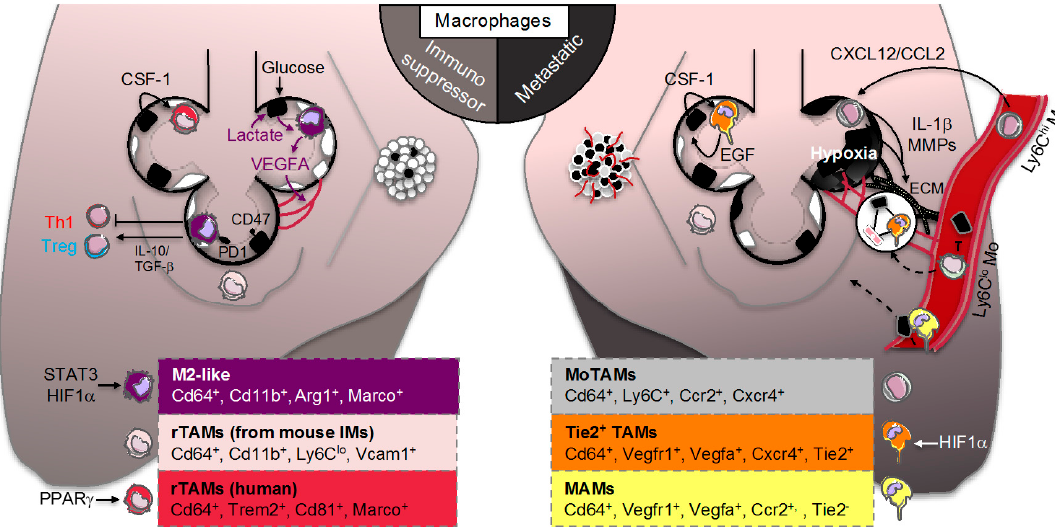
Figure 2. Macrophage effector functions as part of the 7th hallmark of cancer. Right panel: In established tumors, tumor-associated macrophages (TAMs) are the major part of the immune infiltrate that constitutes the tumor microenvironment (TME). Malignant cells produce the colony stimulating factor 1 (CSF-1), which participates to the conversion of tissue-resident macrophages into resident-TAMs (rTAMs). Their origin and cell surface makers may differ between mice and humans, with PPAR γ being highly expressed in human rTAMs. Tumor cells also produce lactate through anaerobic glycolysis referred as the “Warburg effect” that can feed cancer cells in a cell-autonomous fashion for proliferation or act in a paracrine fashion to stabilize the hypoxia-inducible factor 1 α (HIF1 α ) and promote a non-classical “M2-like” macrophage polarization. The signal transducer and activator of transcription 3 (STAT3) is another key transcription factor of M2 polarization. These M2-like macrophages participate to the tumor growth through at least 4 mechanisms: (1) secretion of the angiogenic vascular endothelial growth factor A (VEGFA), (2) expression of the immune checkpoint programmed death-1 (PD-1), (3) defect in recognizing and phagocytosing CD47-expressing tumor cells and (4) immunosuppression through inhibition of Th1 helper cells (Th1) and recruitment of regulatory T cells (Treg). Left panel: TAMs are also involved in more chaotic metastatic tumors. A feed-forward loop between CSF-1-expressing tumor cells and EGF-expressing TAMs contributes to intensive proliferation and oxygen consumption leading to a hypoxic environment. Tumor cells also secrete chemokine ligands such as CXCL12 and CCL2, involved in the recruitment into the tumor site of newly monocyte-derived TAMs (MoTAMs) from circulating Ly6C hi monocytes contributing to the expansion of the tumor and the hypoxic niche. Hypoxia within tumor nest alters tumor cells and surrounding MoTAMs promoting extracellular matrix (ECM) remodeling through secretion of IL-1 β and metalloproteases (MMPs). This remodeling favors the “angiogenic switch”. A population of Tie2 + TAMs, which most likely derives from a subpopulation of circulating Ly6C lo monocytes, is located within the tumor vasculature interacting with mammalian-enabled (MENA)-expressing tumor cells and endothelial cells to further promote angiogenesis and create a metastatic environment. Circulating Ly6C lo monocytes also scavenge tumor materials to prevent tumor invasion whereas metastasis-associated macrophages (MAMs) allow the extravasation of tumor cells into the